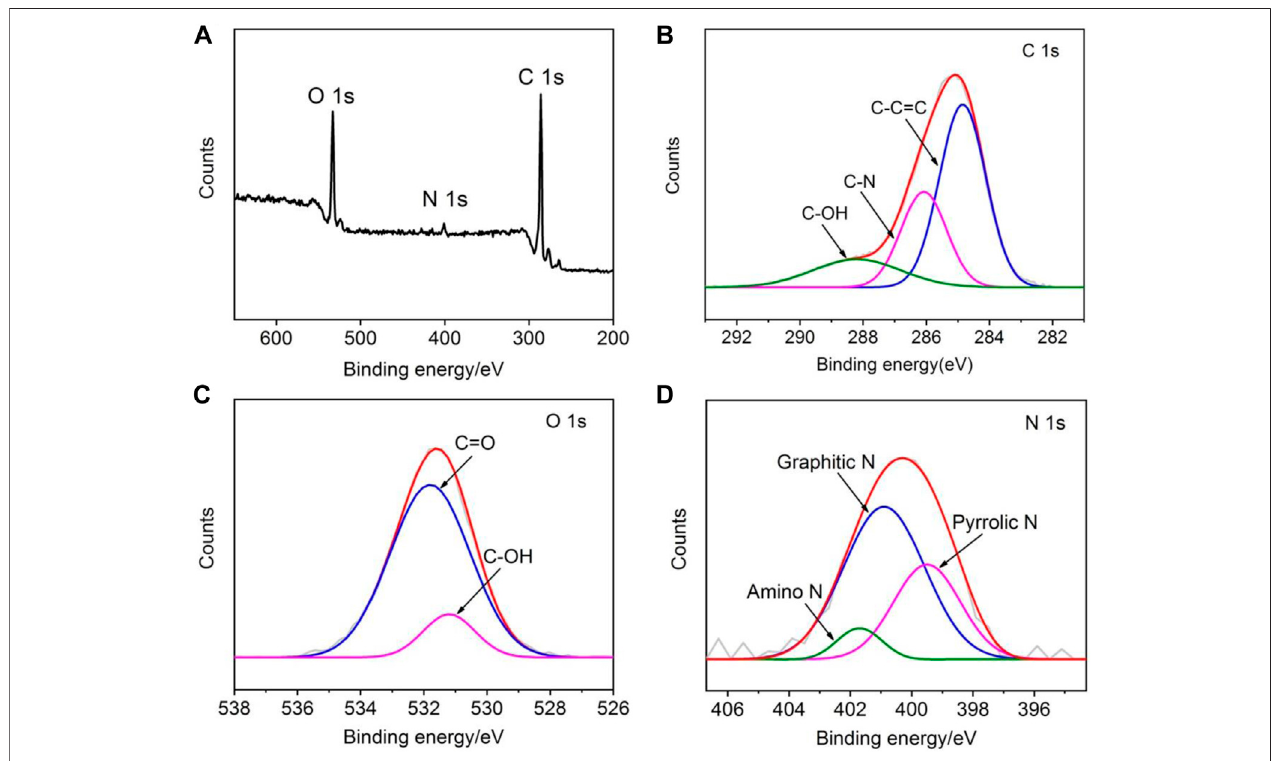
FIGURE 3 | XPS survey spectrum (A) and high-resolution C1s (B) , O1s (C) , and N1s (D) spectra of NGQDs.